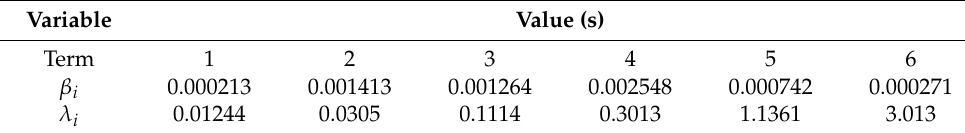
Table 1. Parameters of